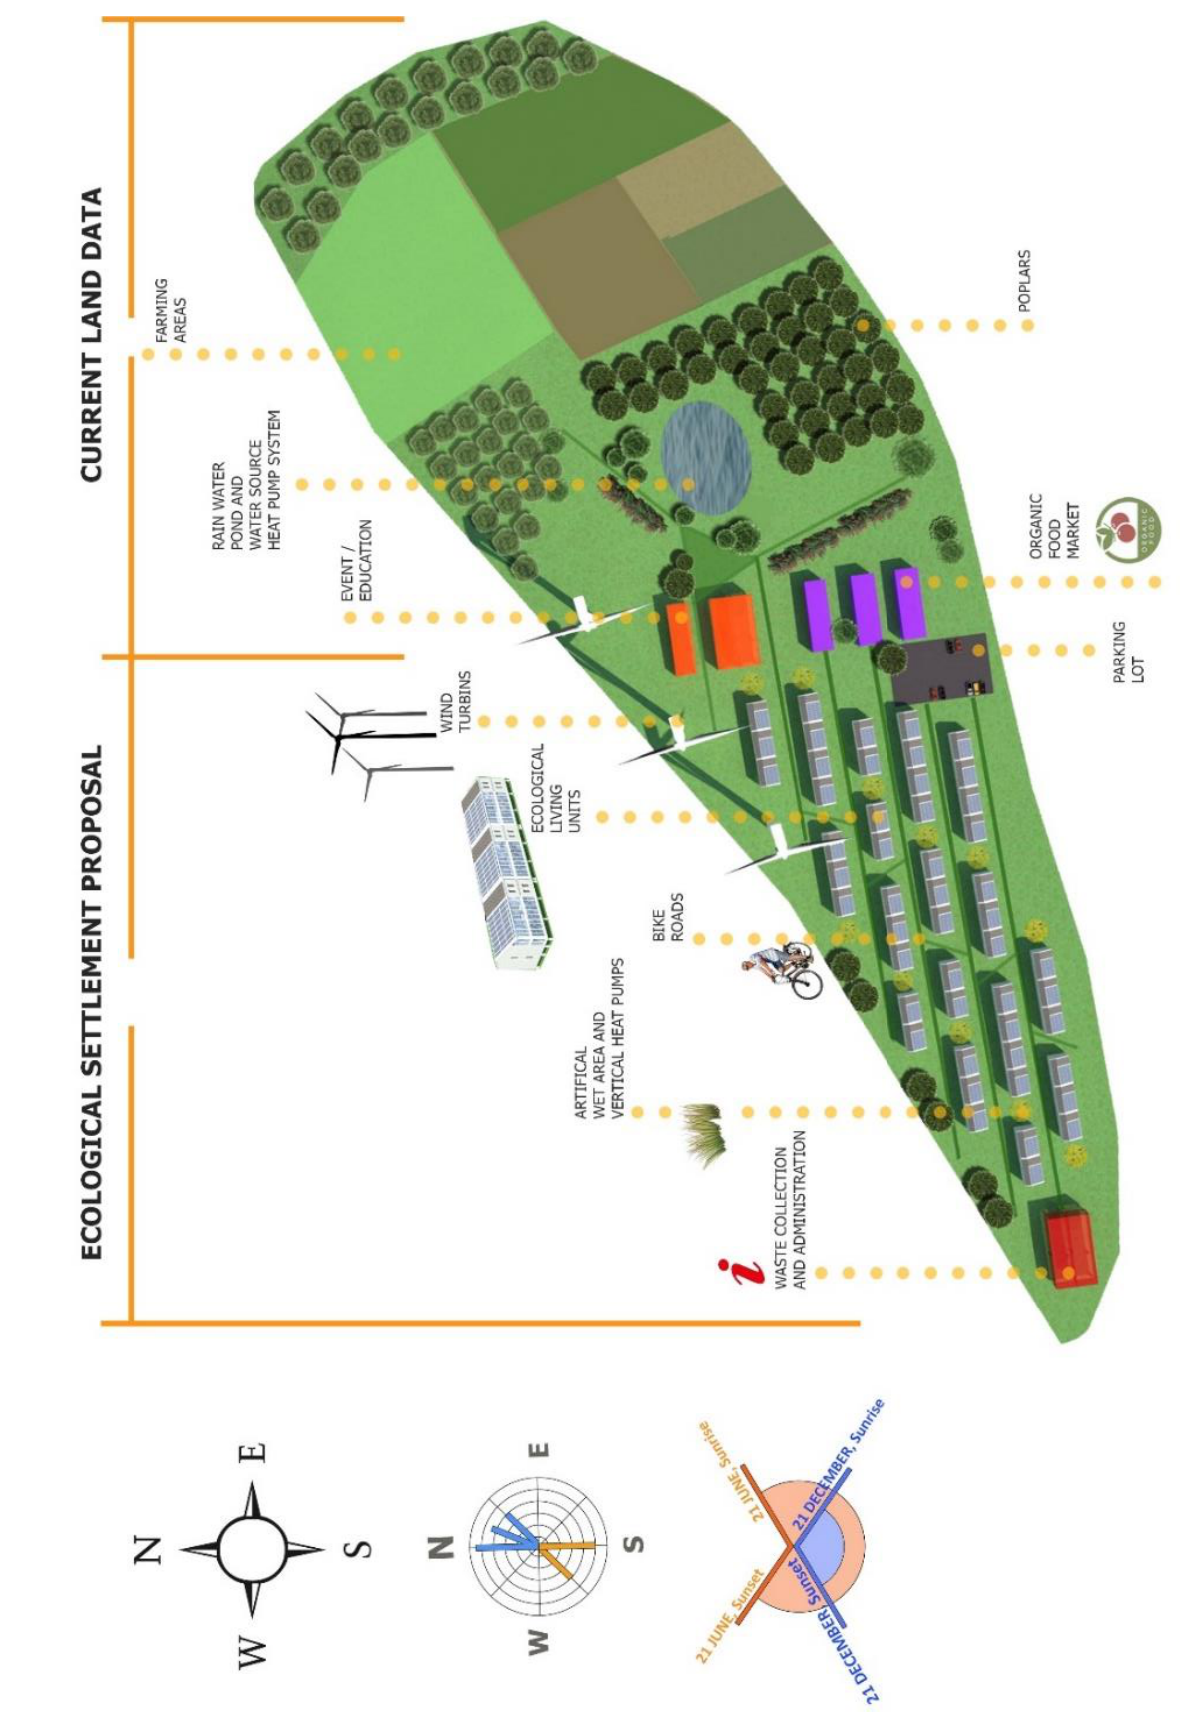
Figure 10. Location and function chart of ecological living